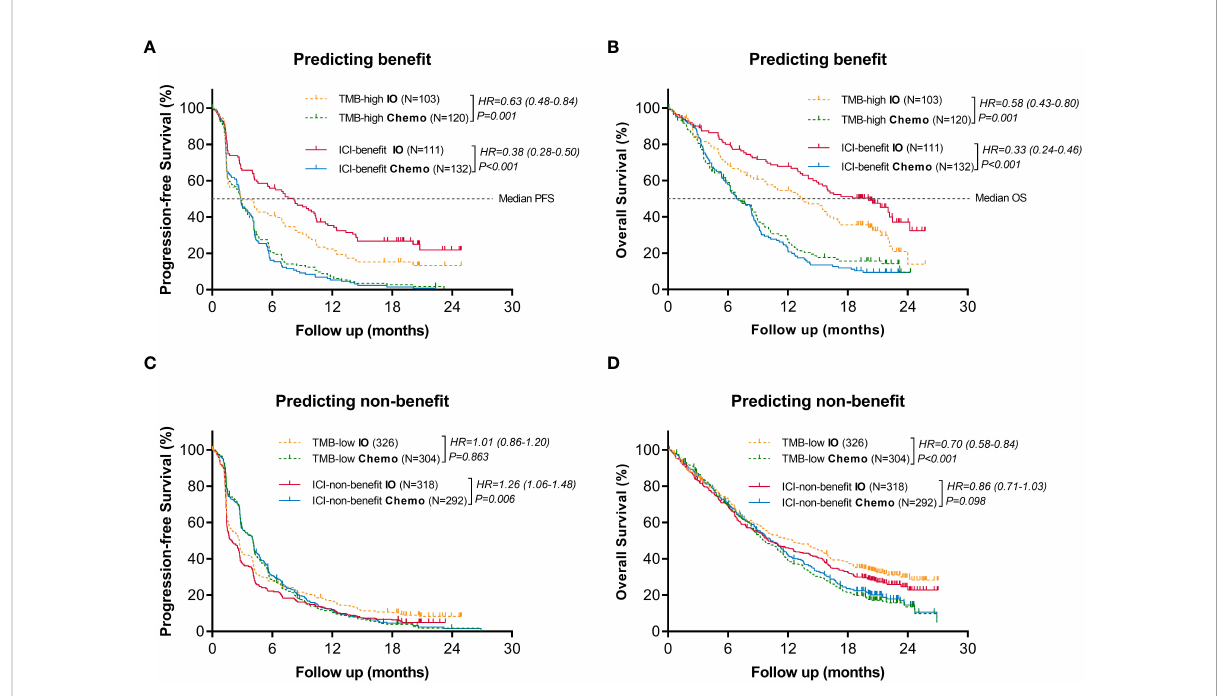
FIGURE 4 Comparison of the survival bene fi ts from immunotherapy vs. chemotherapy between ML-signature and TMB strati fi cation. (A, B) Predicting bene fi t cohort, (C, D) Predicting non-bene fi t